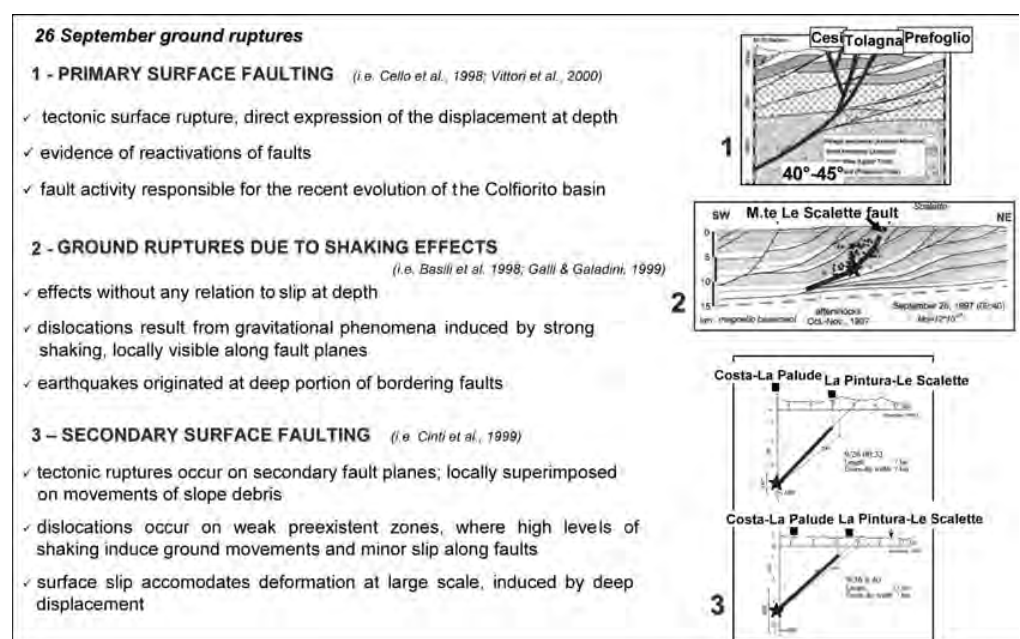
Fig. 10. Three different interpretations of the ground ruptures and of the fault plane geometry associated with the 26 September earthquakes (corresponding sketches to the right): 1) primary surface faulting and listric fault geometry at depth by Cello et al . (1998); 2) blind faulting and shaking-related ground failure by Galli and Ga- ladini (1999); 3) secondary surface slip and postulated geometry of seismogenic fault (assuming constant dip) by Cinti et al . (1999). Sketch to the right: black squares indicate the location of ground ruptures; location of hypocenters and relative errors are from Amato et al .